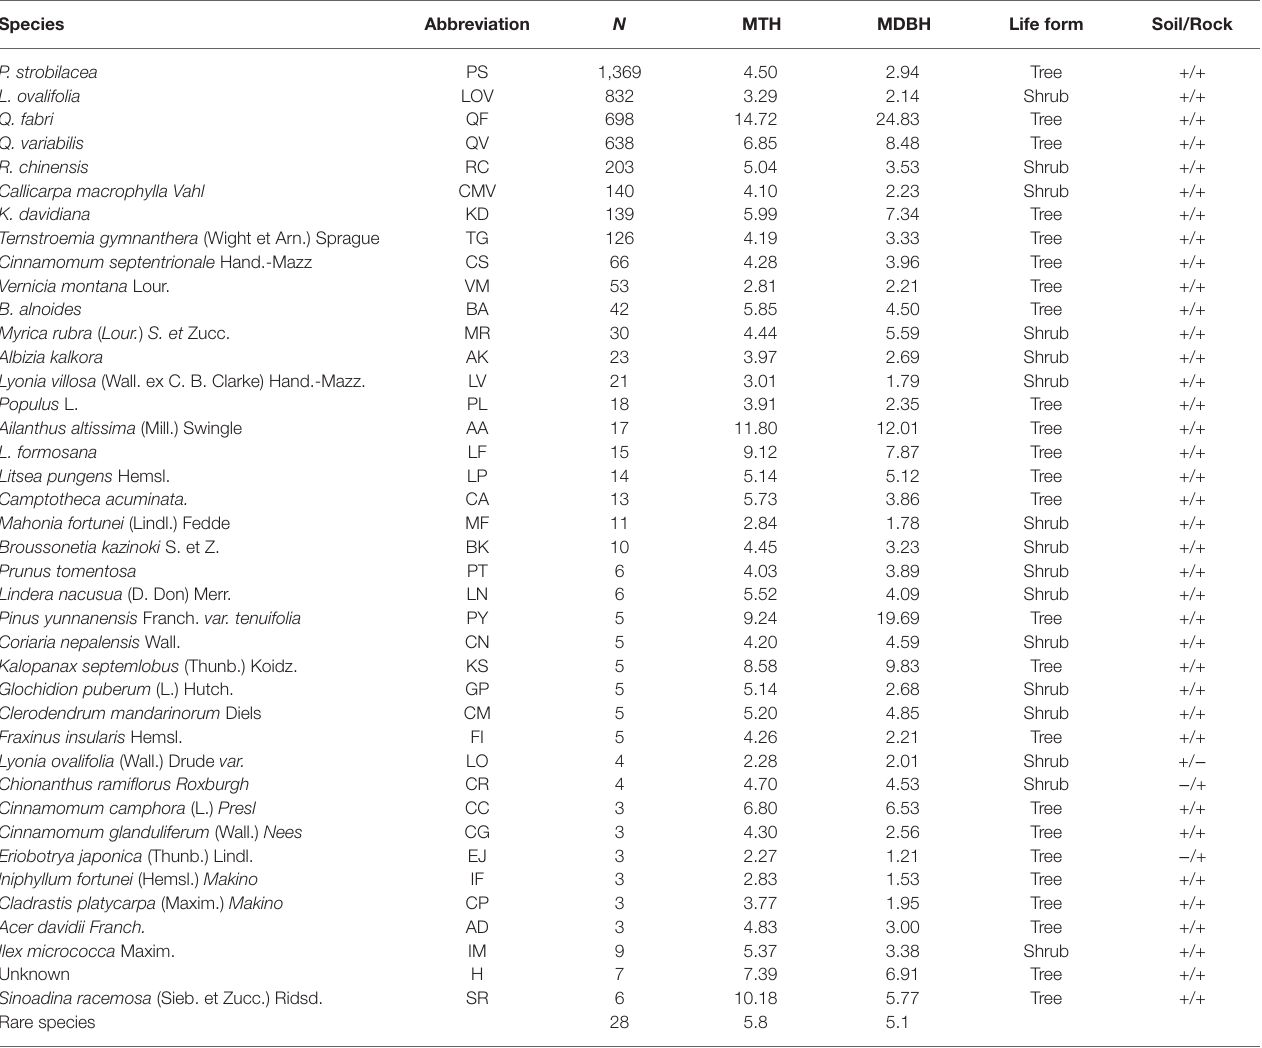
TABLE 1 | Species composition of old-growth oak forest located at karst terrain.